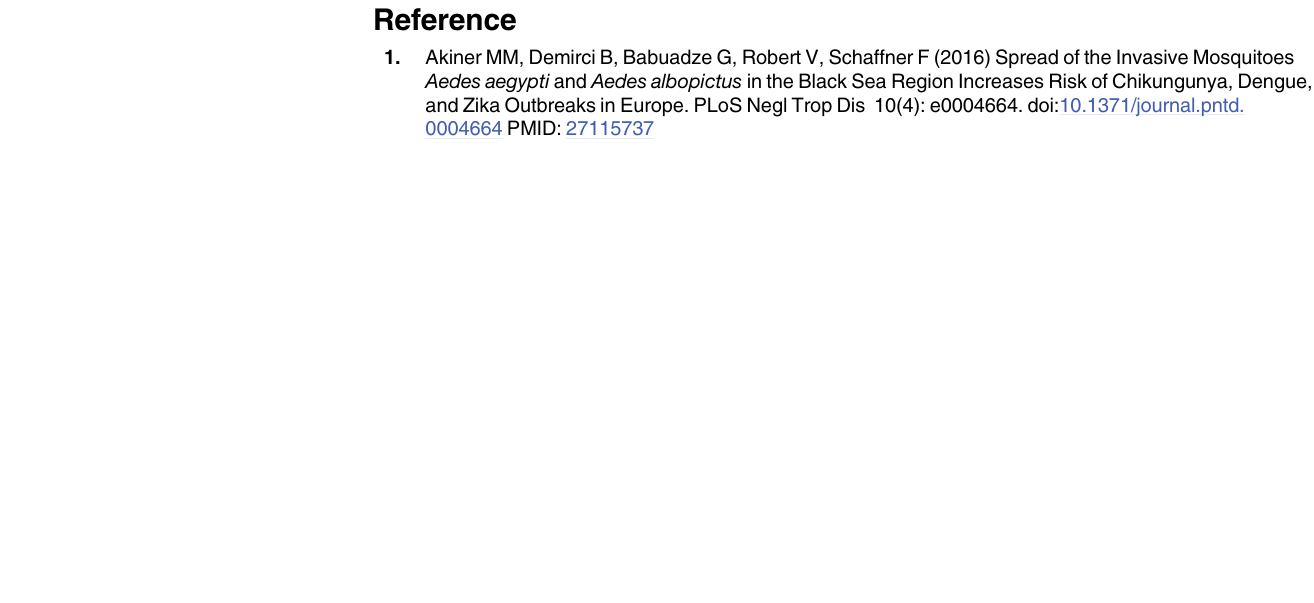
and Zika Outbreaks in Europe. PLoS Negl Trop Dis 10(4): e0004664. doi:10.1371/journal.pntd. 0004664 PMID: 27115737